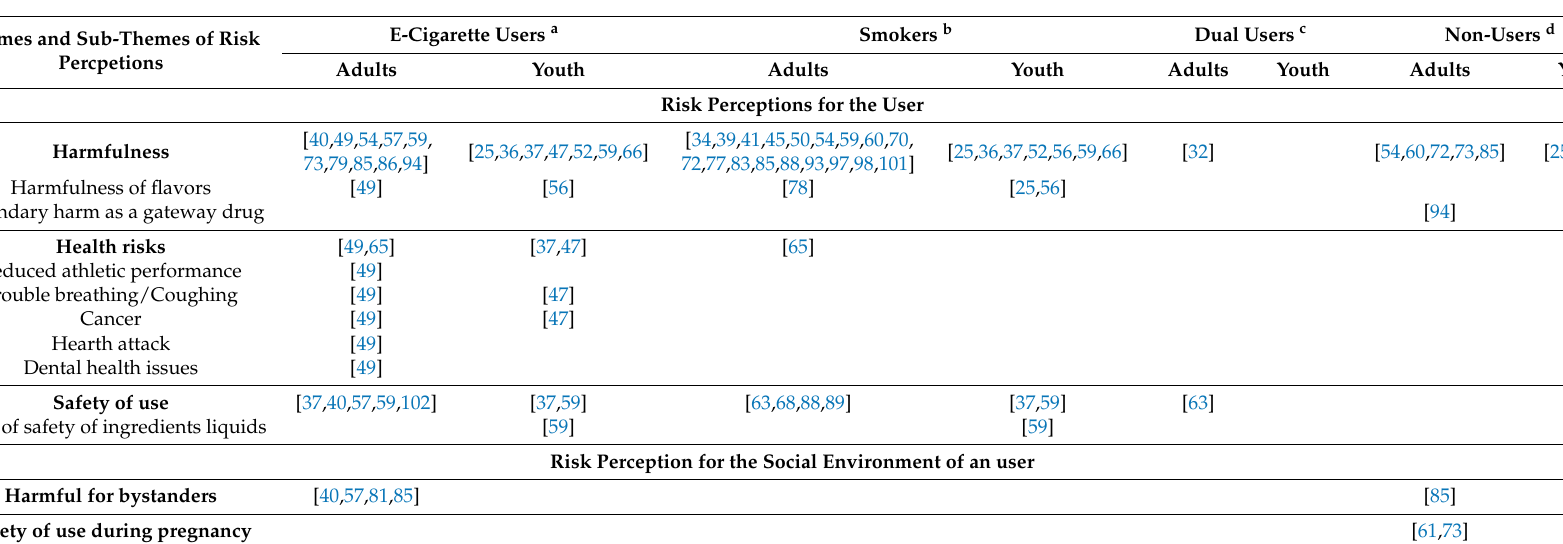
Table 1. Risk perceptions about e-cigarettes reported by individual studies, clustered by type of